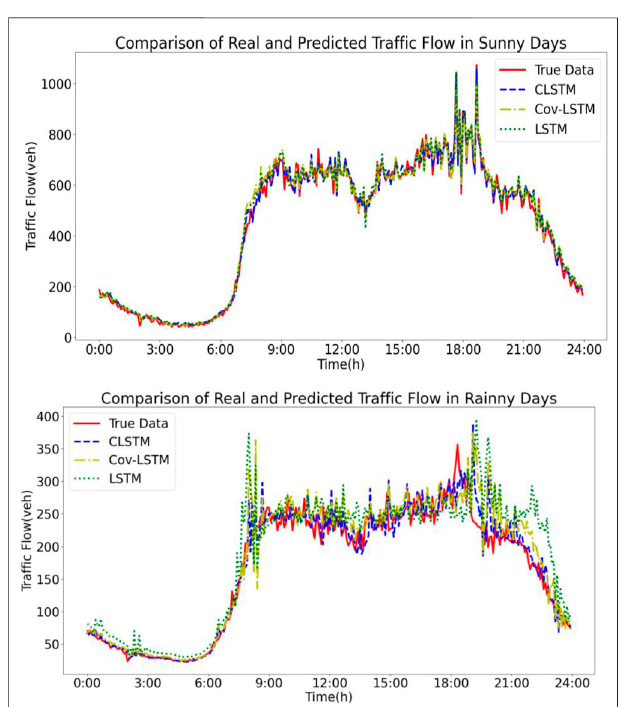
FIGURE 9 | Comparison of real and predicted traf fi c fl ows under different weather